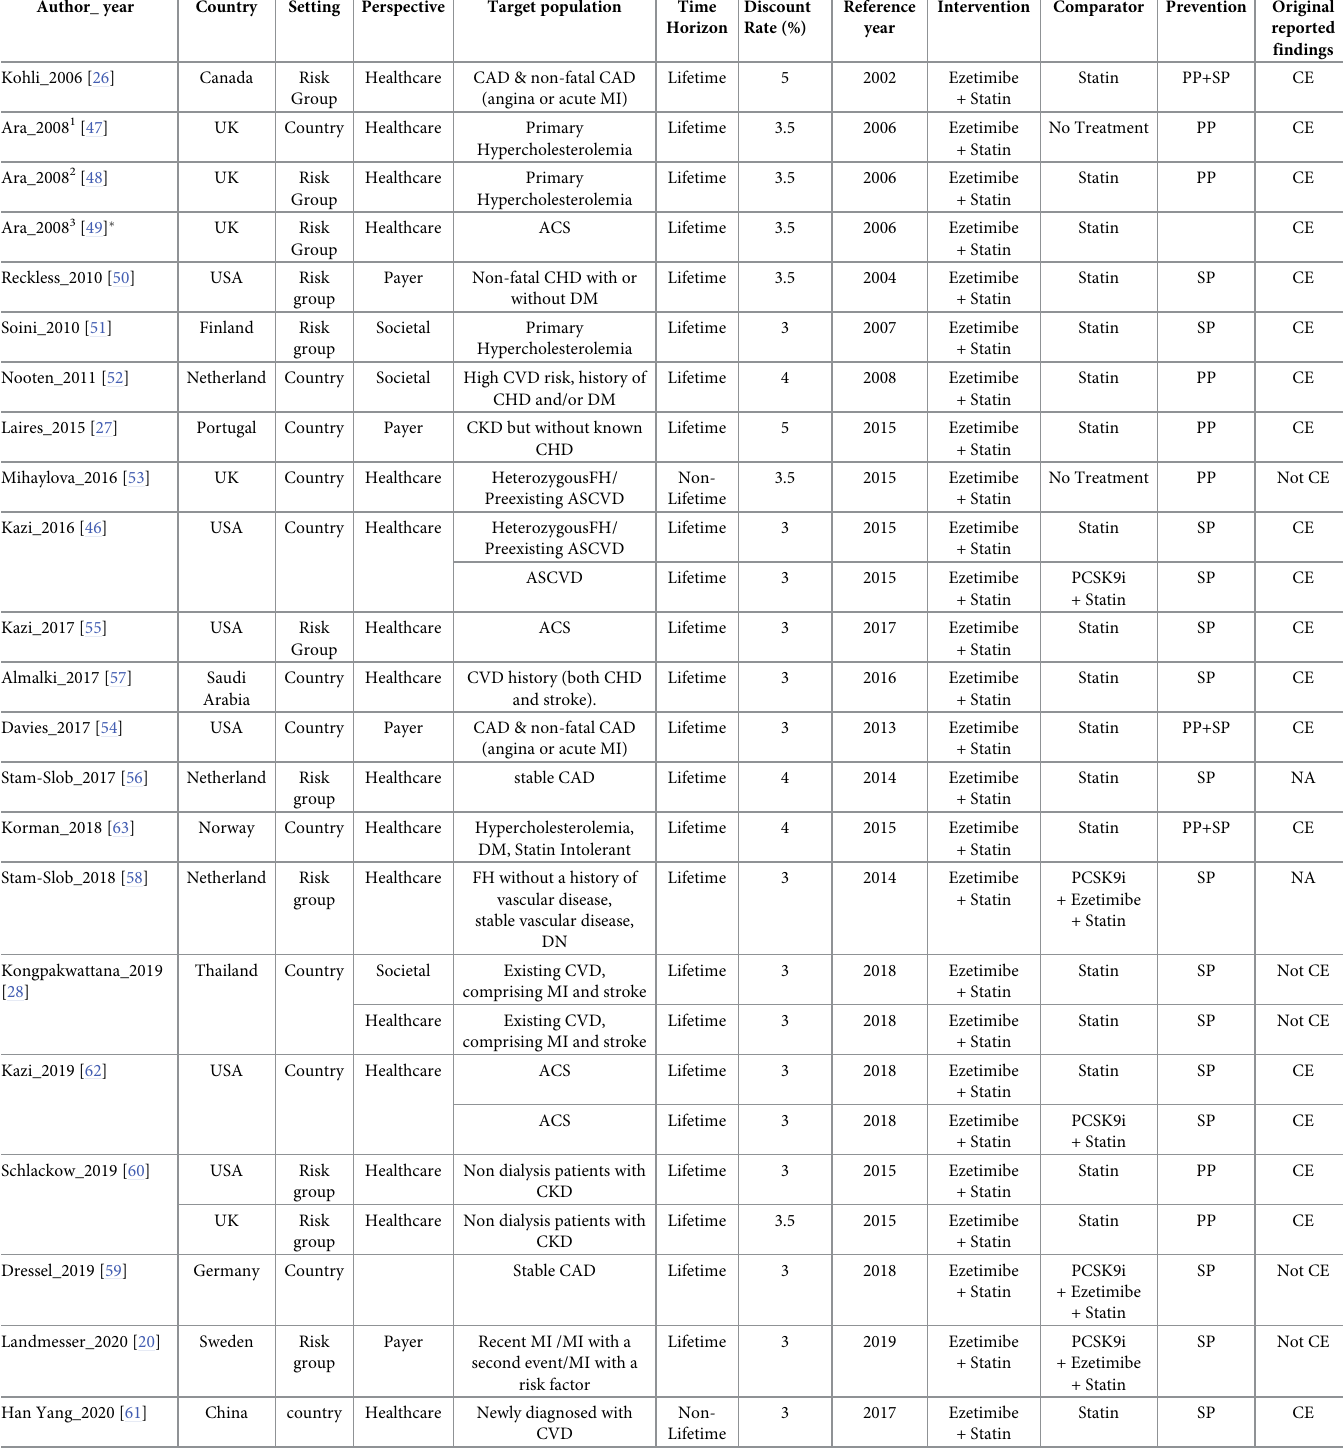
Table 1. Characteristics of identified studies for systematic review and